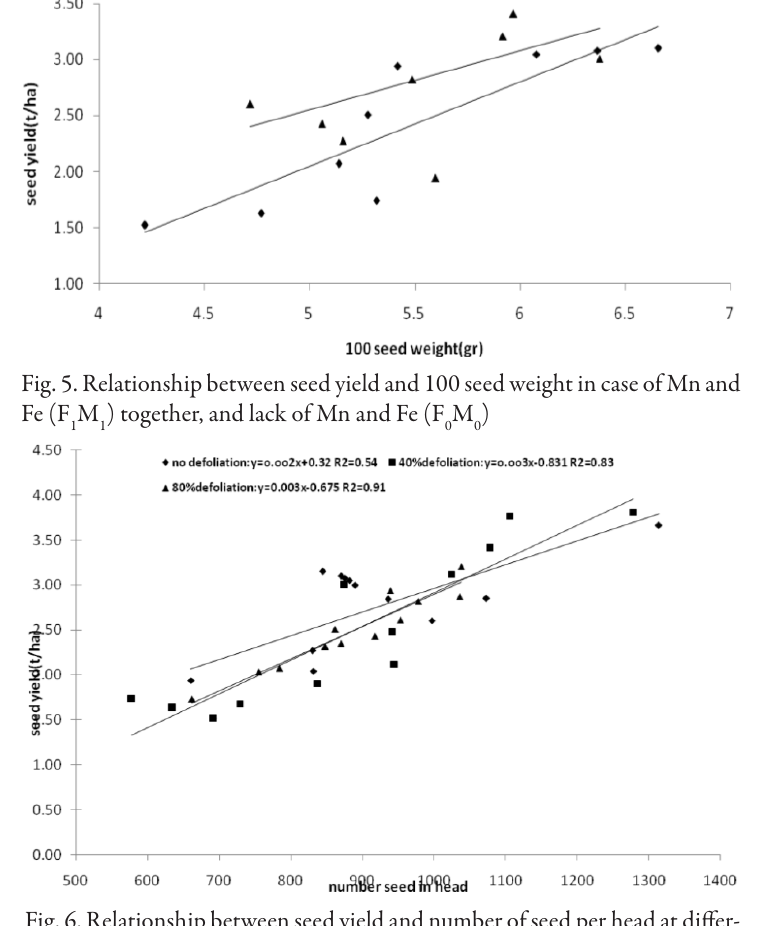
Fig. 6. Relationship between seed yield and number of seed per head at differ- ent defoliation treatments in